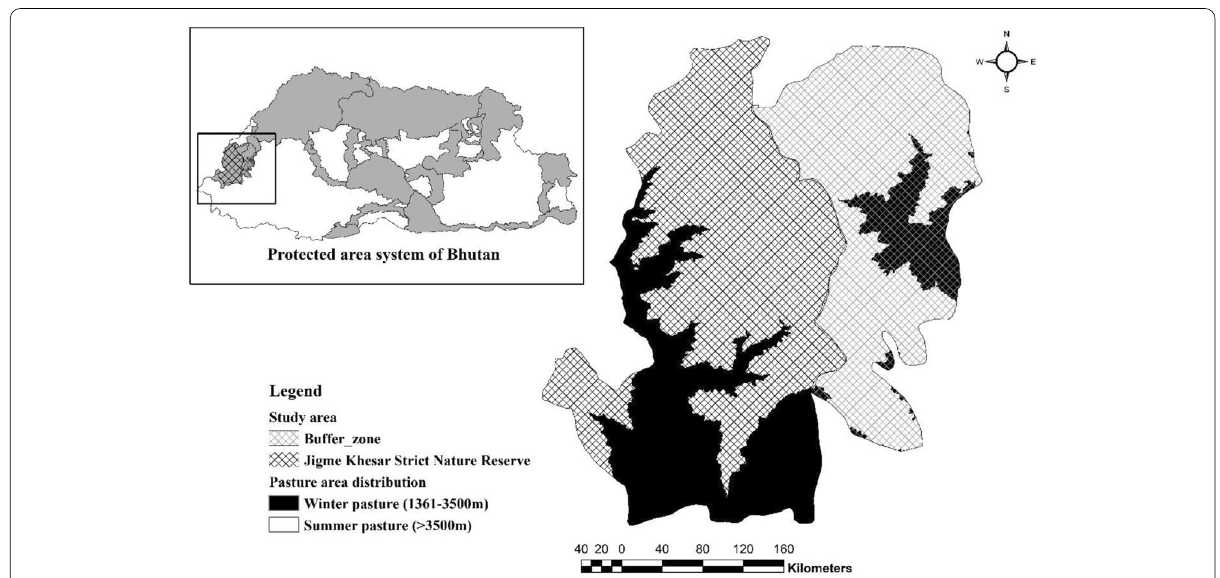
Fig. 1 Study site in the western Bhutan where yak farming is